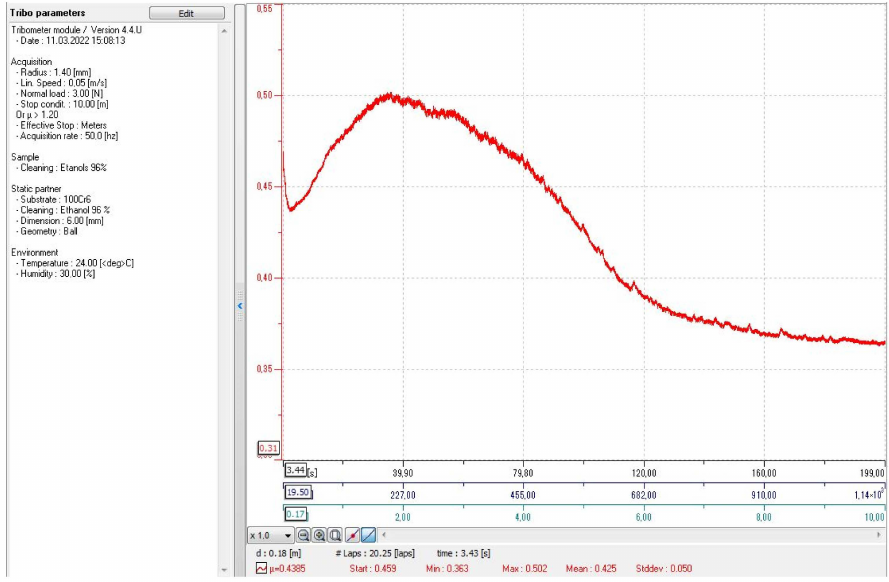
Figure 9. Coefficient of friction versus time, cycles,